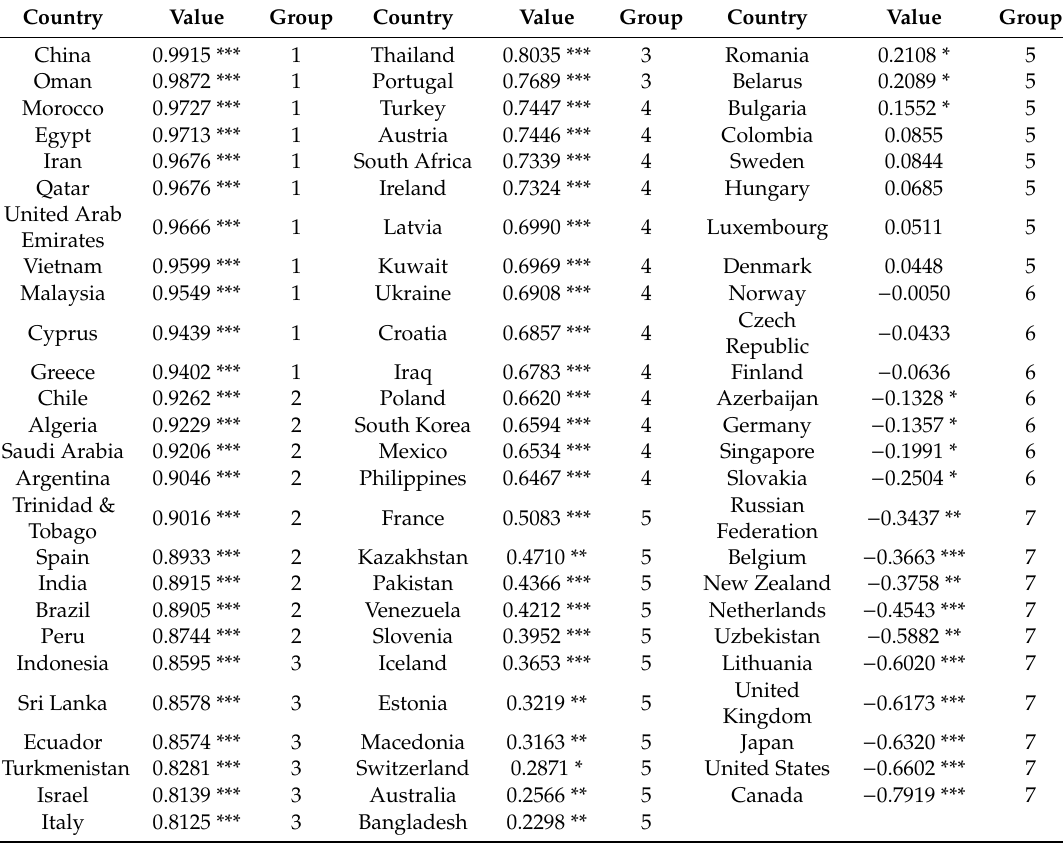
Table 3. Correlation coefficients of every country.